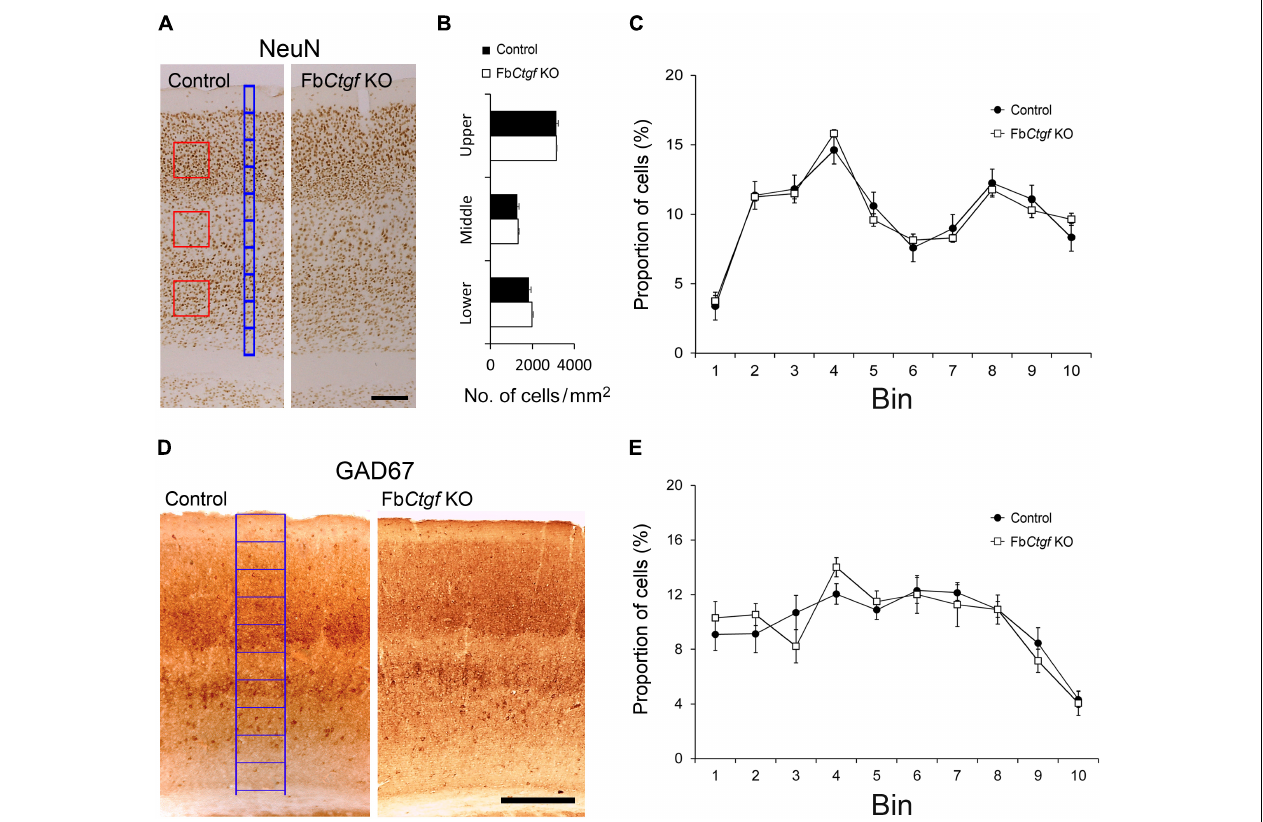
FIGURE 5 | Density and distribution of neurons in the somatosensory cortex. Neurons were labeled with pan-neuronal markers, NeuN (A) . Counting squares of 200 µ m × 200 µ m (red squares) were given to the upper (layers II–IV), middle (layer V), and lower (layer VIa) regions of the cortex. The densities of NeuN-positive neurons in the cortex were estimated in control and Fb Ctgf KO mice (B) . The distribution of cortical neurons was measured using 10 counting bins of 50 µ m in width (blue bins) from the pia surface to the edge of the white matter. In this system, from the top, bin 1 roughly corresponds to cortical layer I, bins 2–3 to layer II/III, bin 4 to layer IV, bins 5–7 to layer V, and bins 8–10 to layer VI, respectively. The distributions of NeuN-positive neurons were similar between control and Fb Ctgf KO mice (C) . Inhibitory neurons in the somatosensory cortex were revealed with GAD67 immunostaining (D) . The distribution of inhibitory cortical neurons was measured using 10 counting bins of 150 µ m in width (blue bins) from the pia surface to the edge of white matter. The distributions of GAD67-positive neurons were similar between control and Fb Ctgf KO mice (E) . Scale bars are 200 µ m. n = 5 in each genotype. Results are means ±